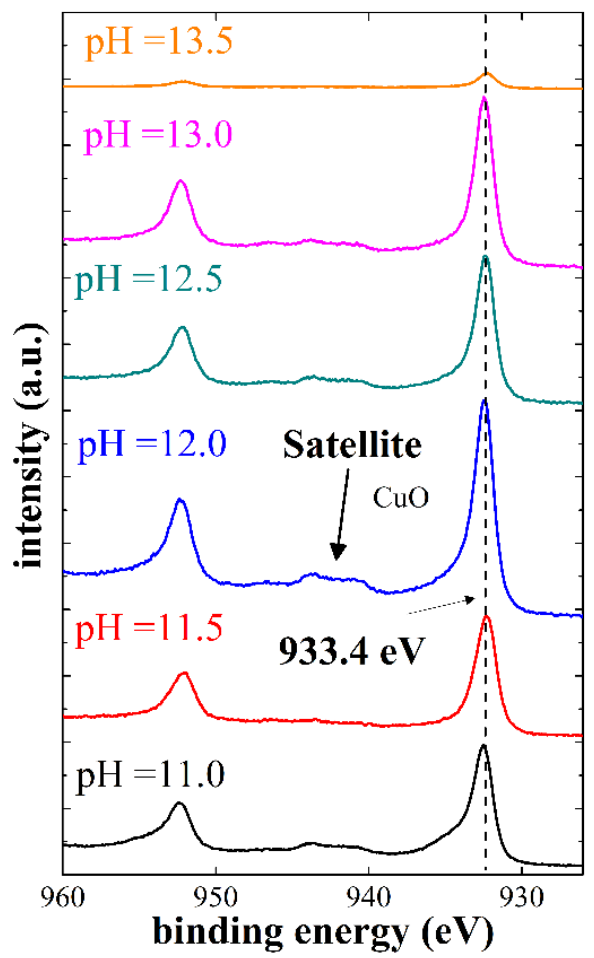
Figure 6. XPS spectra of Cu2p core level of the CuO films obtained at different pH values. Table 1. Concentration (at%) of O1s and Cu2p 3/2 of the MWCBD-CuO films obtained at different pH values.